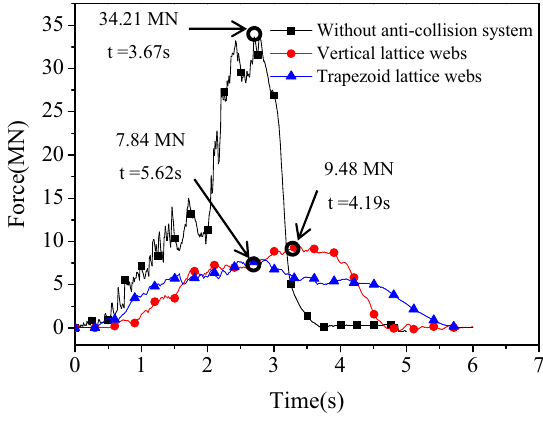
Figure 22: Load – time curve of the ship impact bridge. ( Note: t represents the time duration.